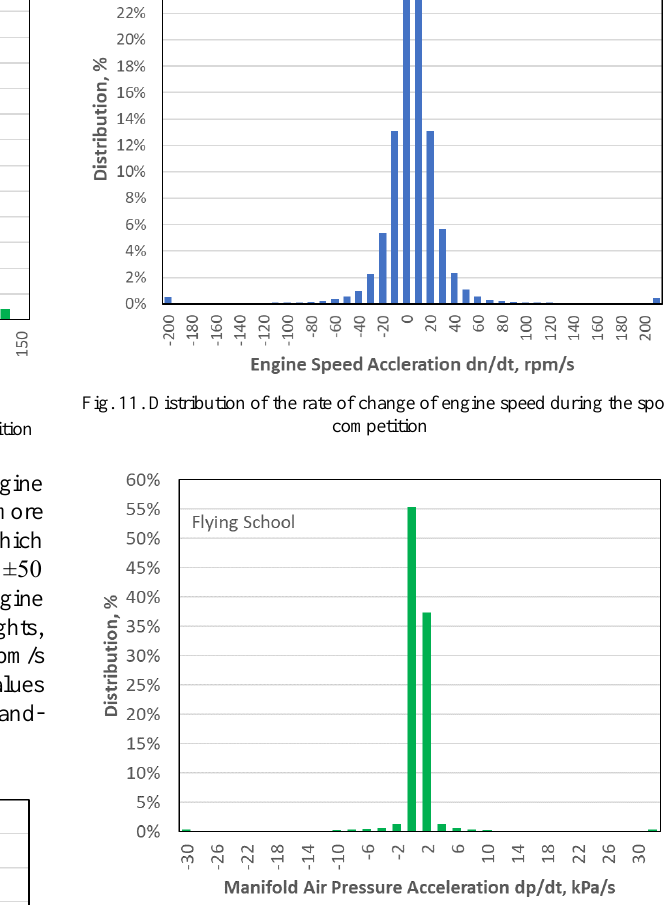
Fig. 12. Distribution of the rate of change of manifold air pressure during training flights